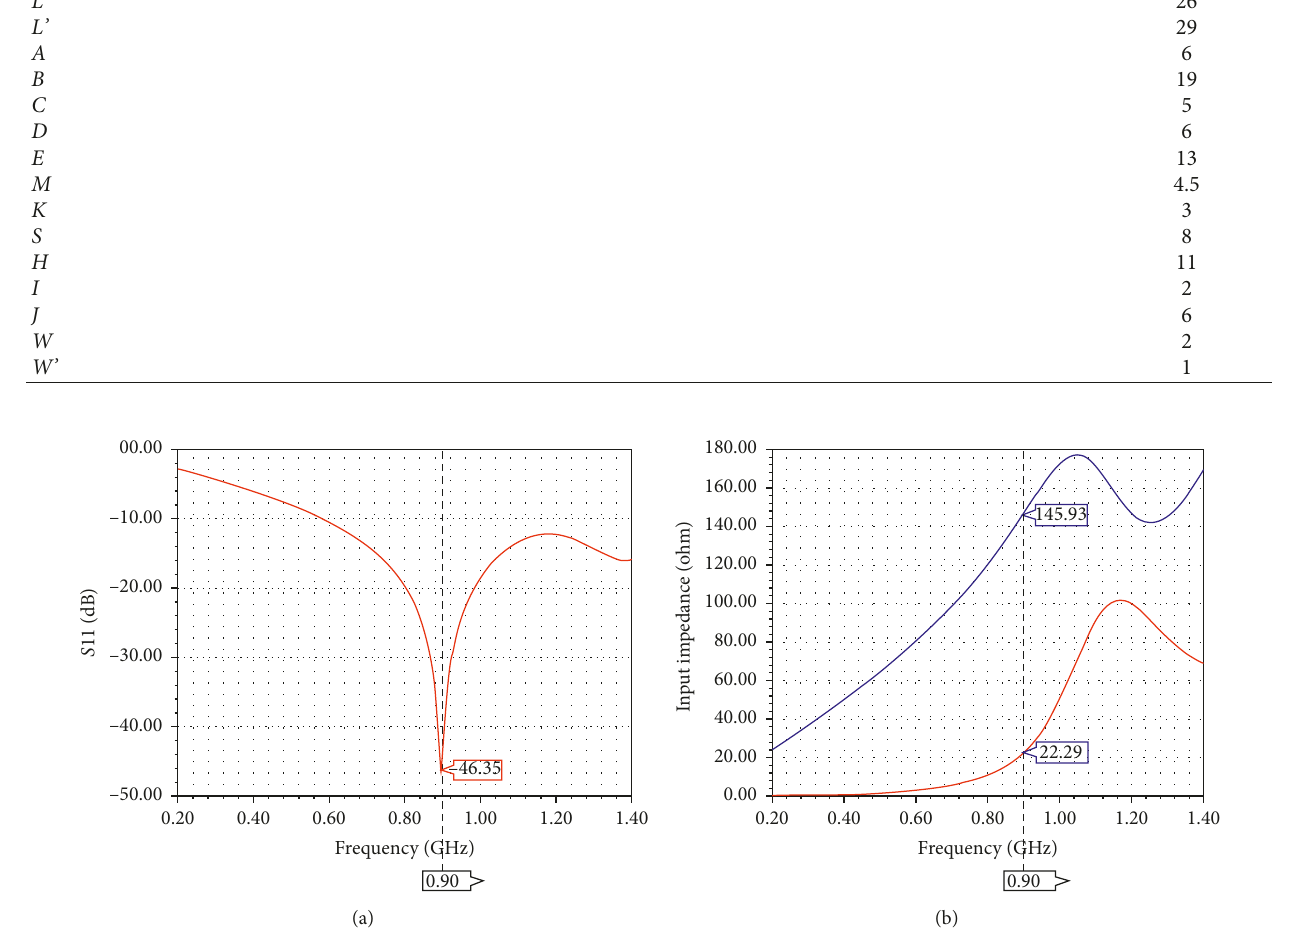
Figure 14: Simulated S 11 (a) and antenna input impedance (b) of the epidermal double-loop tag with meandered lines in two directions.